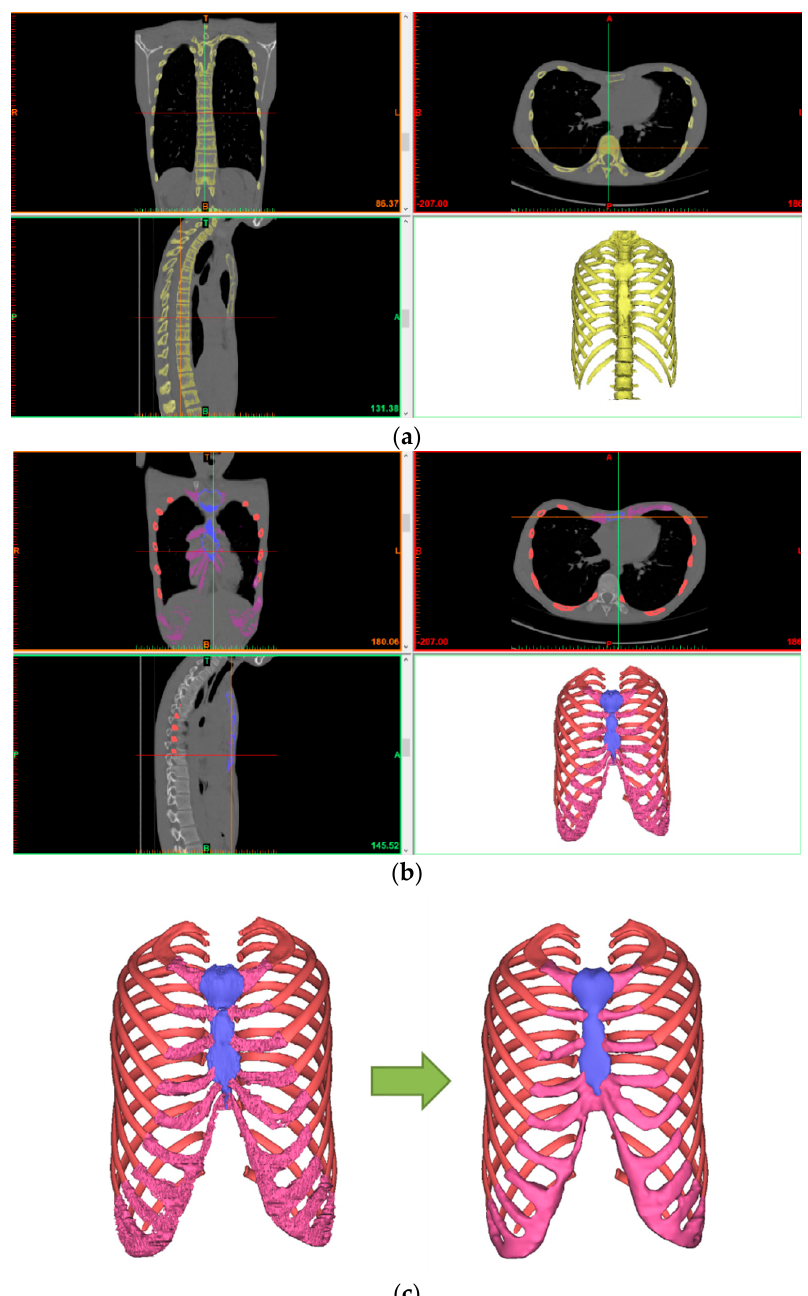
Figure 2. Fabrication procedure for the 3D chest wall model for a PE patient: ( a ) Step 1; ( b ) Steps 2 and 3; ( c ) Step 4.